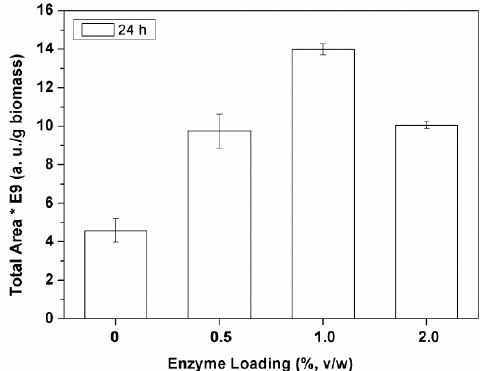
Figure 3. Effect of the enzyme loading on the Alcalase ® assisted extraction of the polar spirulina biocomponents. Variation of total peak areas in the HPLC-ELSD analyses relative to 1 g biomass. Conditions: 30 ºC and pH 6.5; A.U.: arbitrary units.